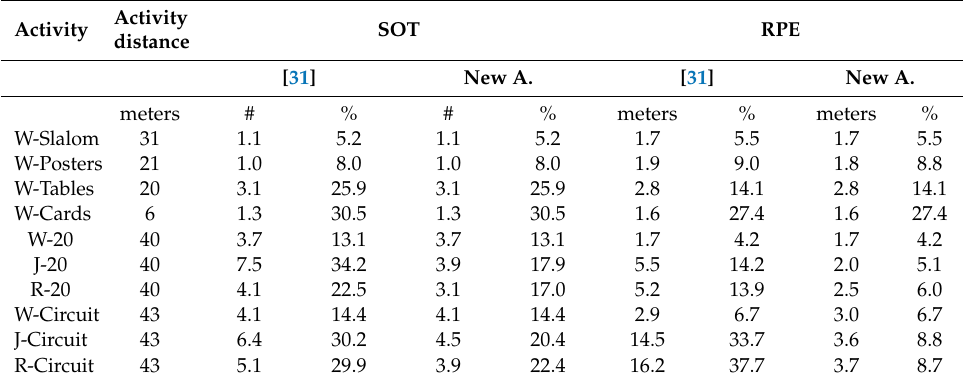
Table 6. Averaged results of trajectory reconstruction of activities performed by the 56 participants in the FAU dataset using the previous and the proposed TO and MS detection